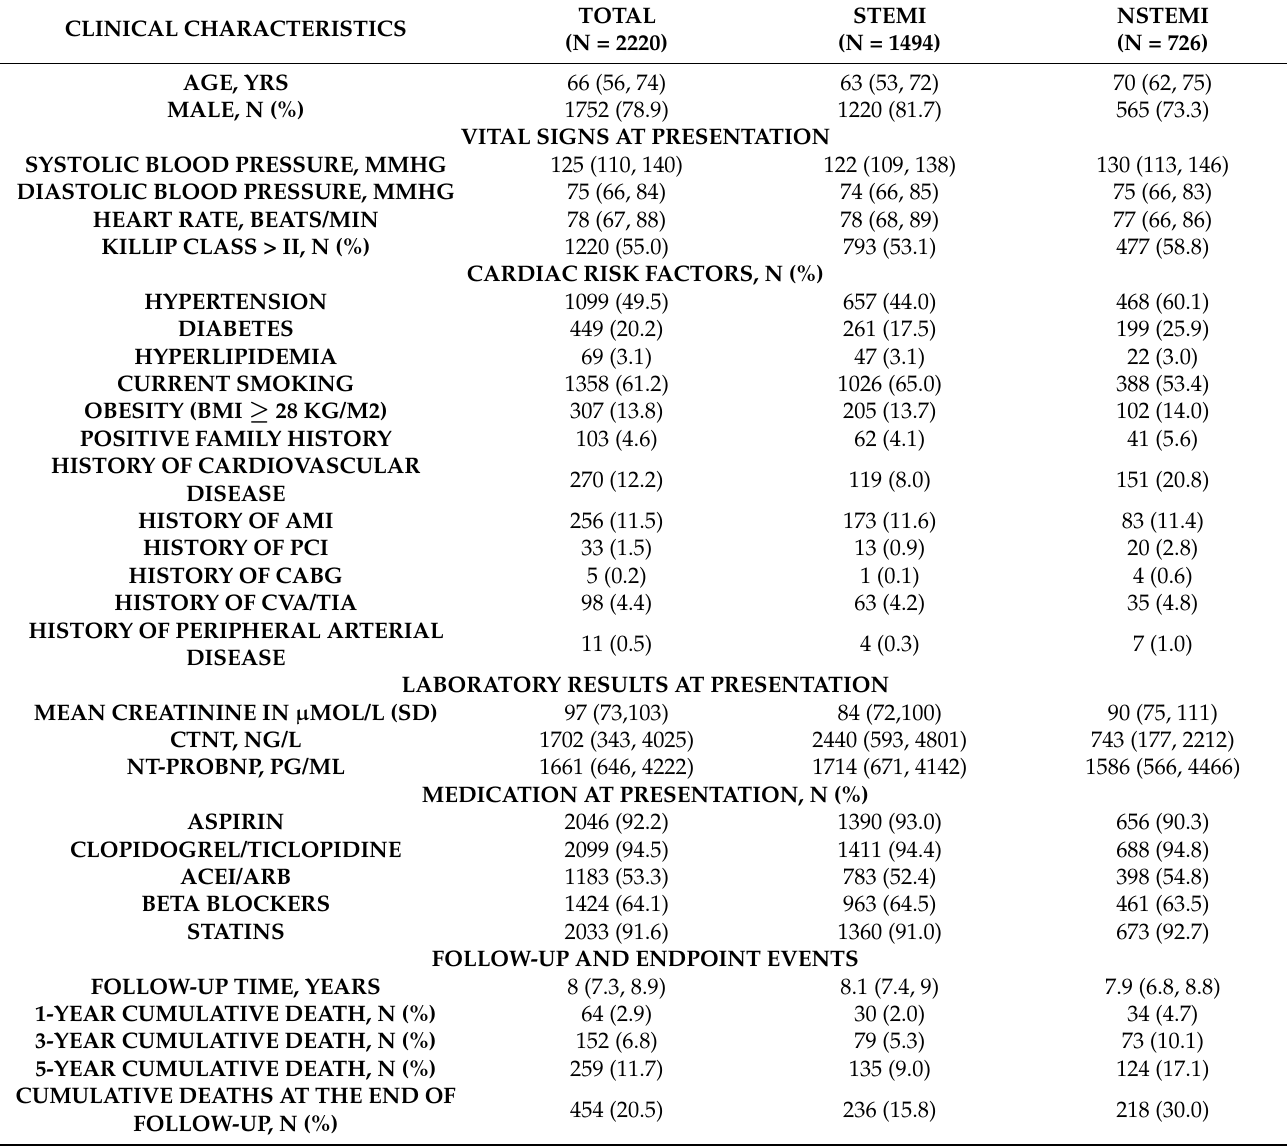
Table 2. Baseline characteristics of